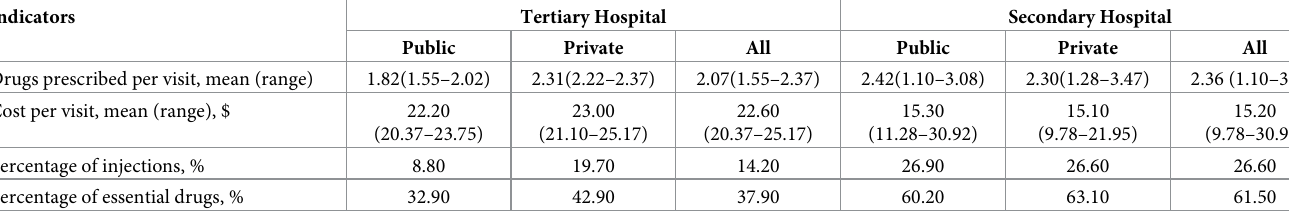
Table 4. Indicators of drug prescribing in different levels of hospitals.